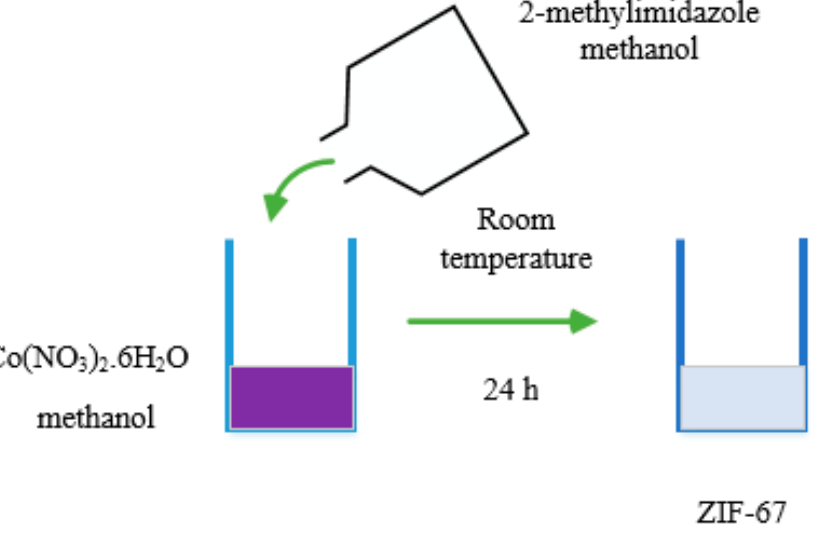
Figure 3. Synthesis process of solvothermal methods.